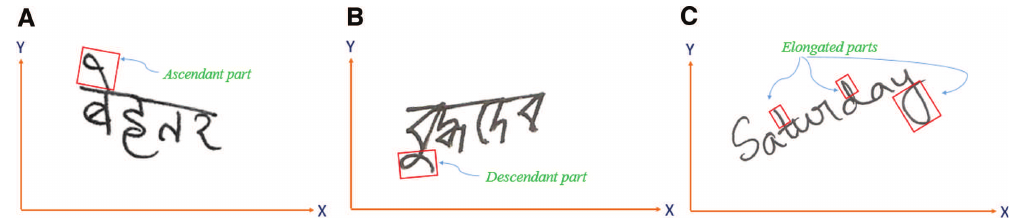
Figure 1: Sample Word Images with (A) Ascendant, (B) Descendant, and (C) Elongated Parts.